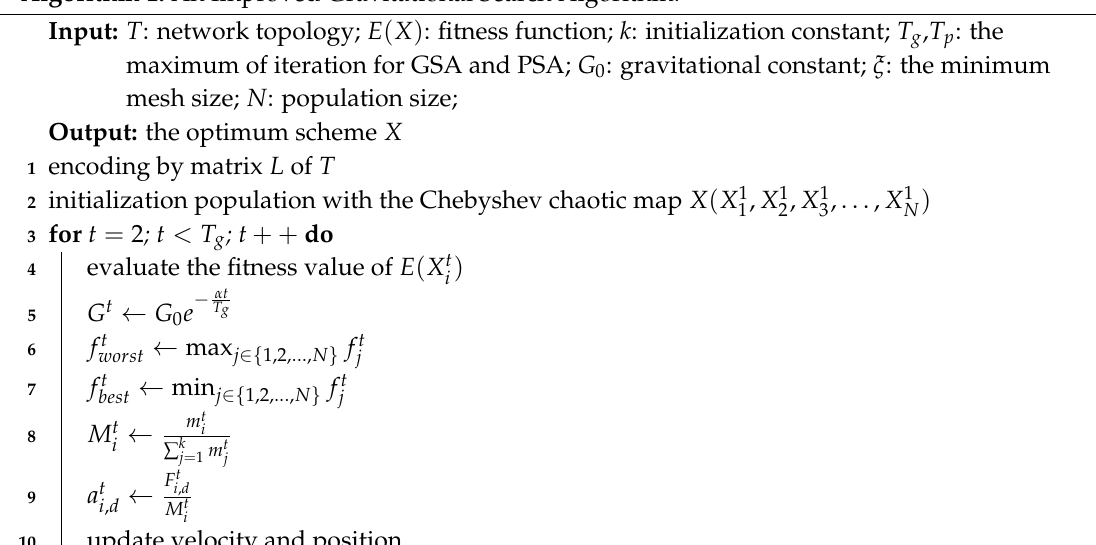
Algorithm 1: An Improved Gravitational Search